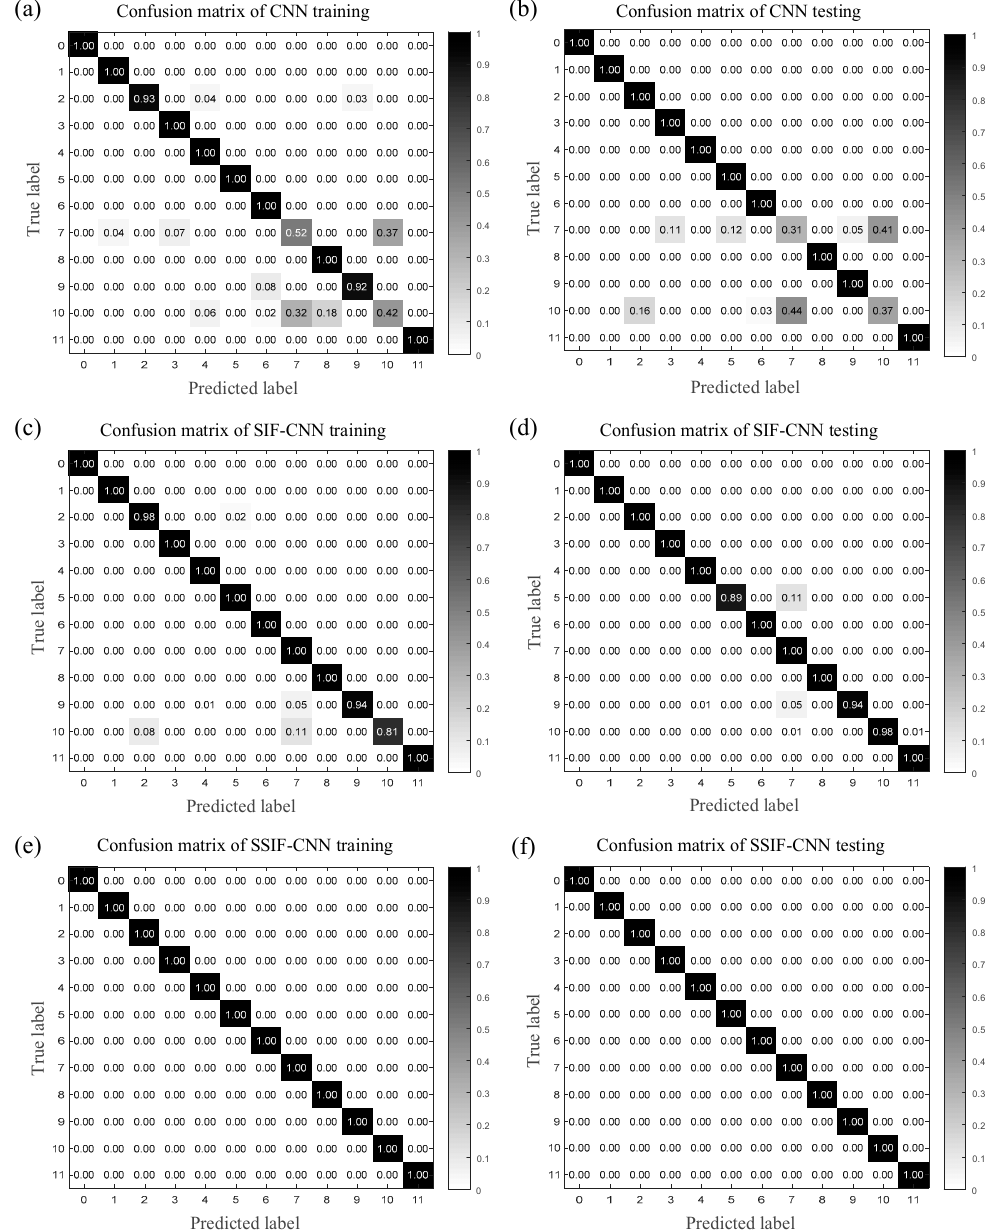
Figure 8. Confusion matrix of the three models for the first trial.